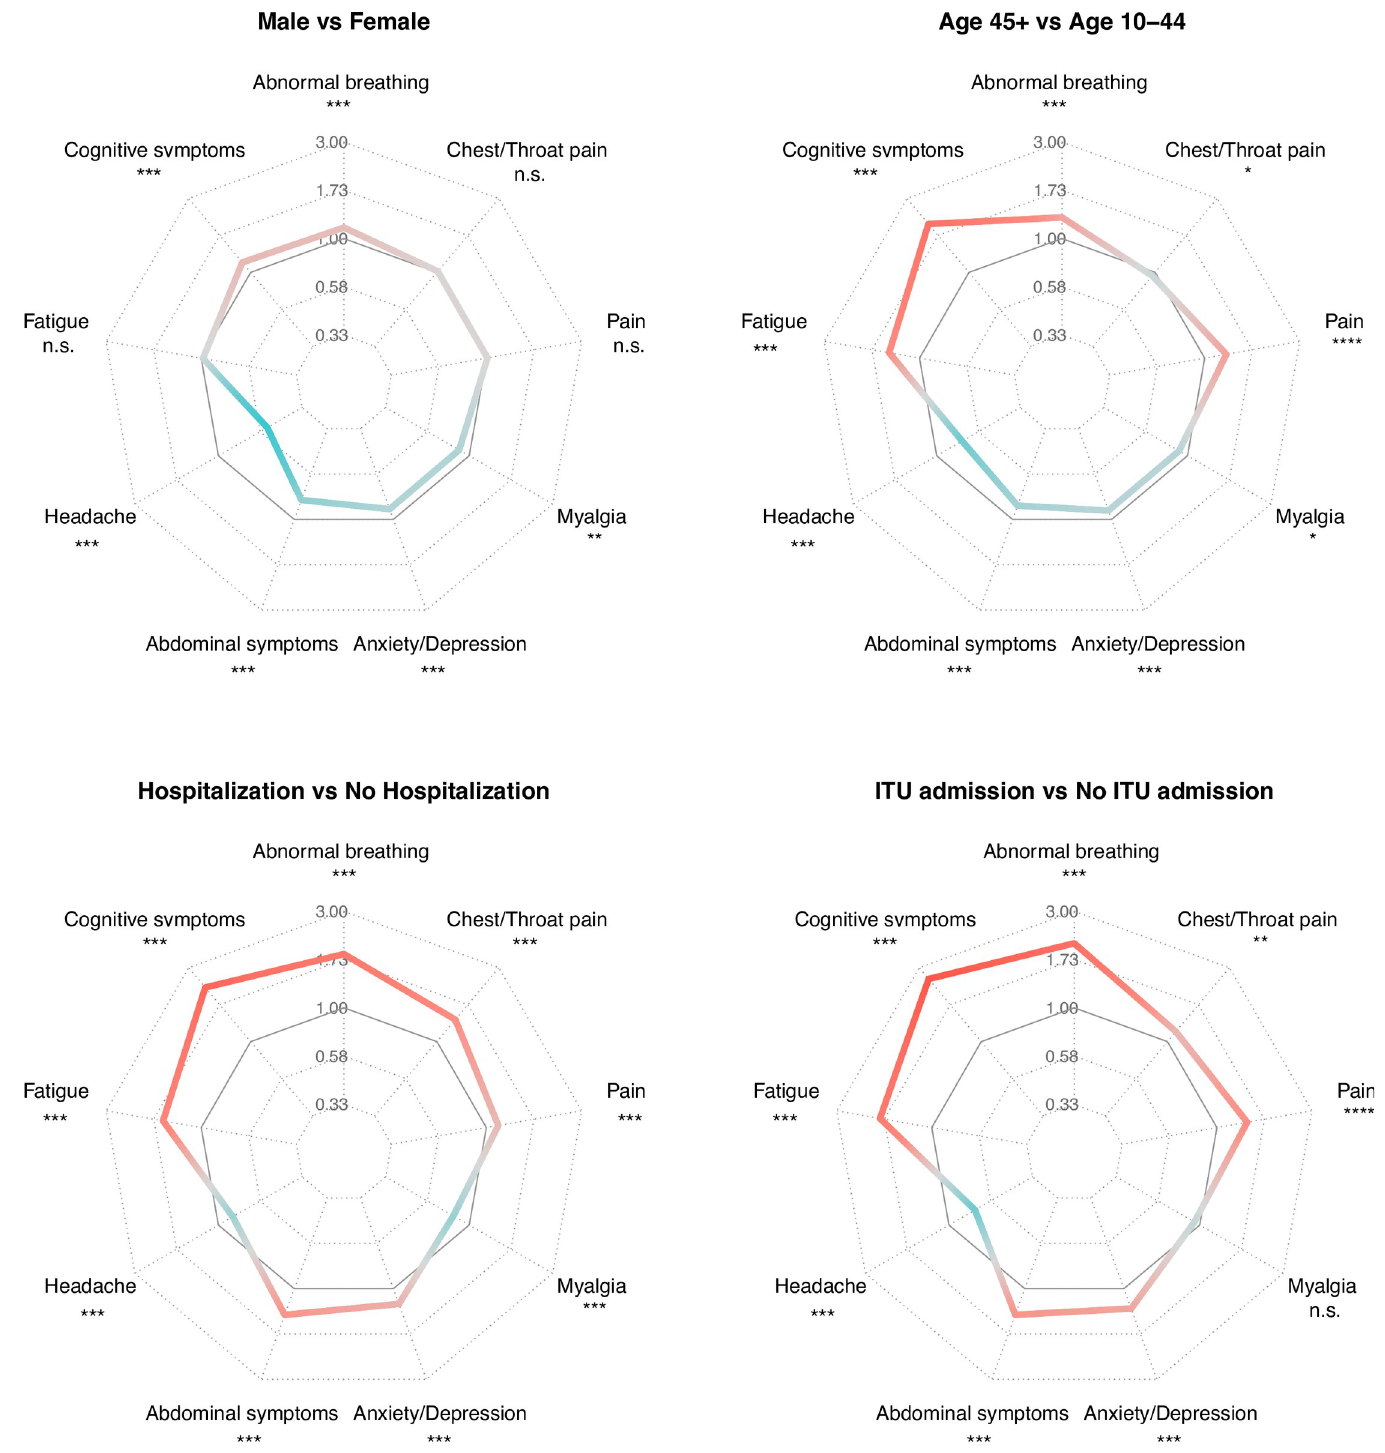
Fig 5. Spider plots summarizing the HRs for each long-COVID feature in subgroups based upon sex, age, and severity of COVID-19 as proxied by requiring hospitalization or ITU admission. HRs are shown comparing the first named group with the second named group. HRs greater than 1 are in red; HRs less than 1 in blue. Significance indicated by asterisks, � p < 0.05, �� p < 0.01, ��� p < 0.001. Each comparison is based on propensity score–matched cohorts; for baseline characteristics, see Tables M-T in S1 Tables). For spider plots of all subgroup analyses, see Fig AE in S1 Fig. COVID-19, Coronavirus Disease 2019; HR, hazard ratio; ITU, intensive treatment